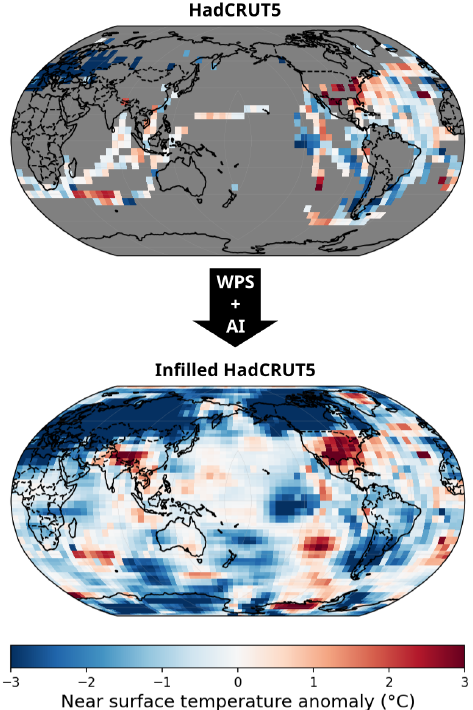
Figure 3. Illustration of the infilling process of the HadCRUT5 dataset. Top figure: original HadCRUT5 data for January 1850. Bottom figure: same as top figure where the missing data have been infilled using our deep learning based inpainting